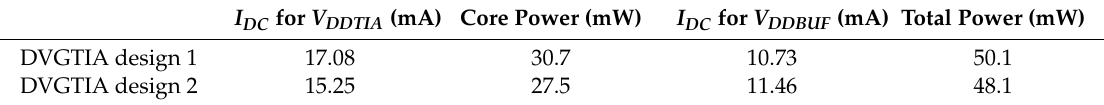
Figure 8. Measurement setup for S-parameters and input referred 1 dB compression point. The measured DC currents for (cid:1848) (cid:3005)(cid:3005)(cid:3021)(cid:3010)(cid:3002) and (cid:1848) (cid:3005)(cid:3005)(cid:3003)(cid:3022)(cid:3007) are shown in Table 3: Table 3. Measured DC currents for voltage power supply.